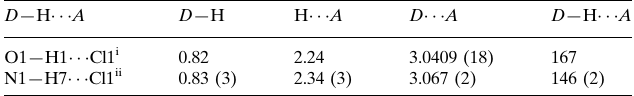
Hydrogen-bond geometry (A˚ , (cid:3)